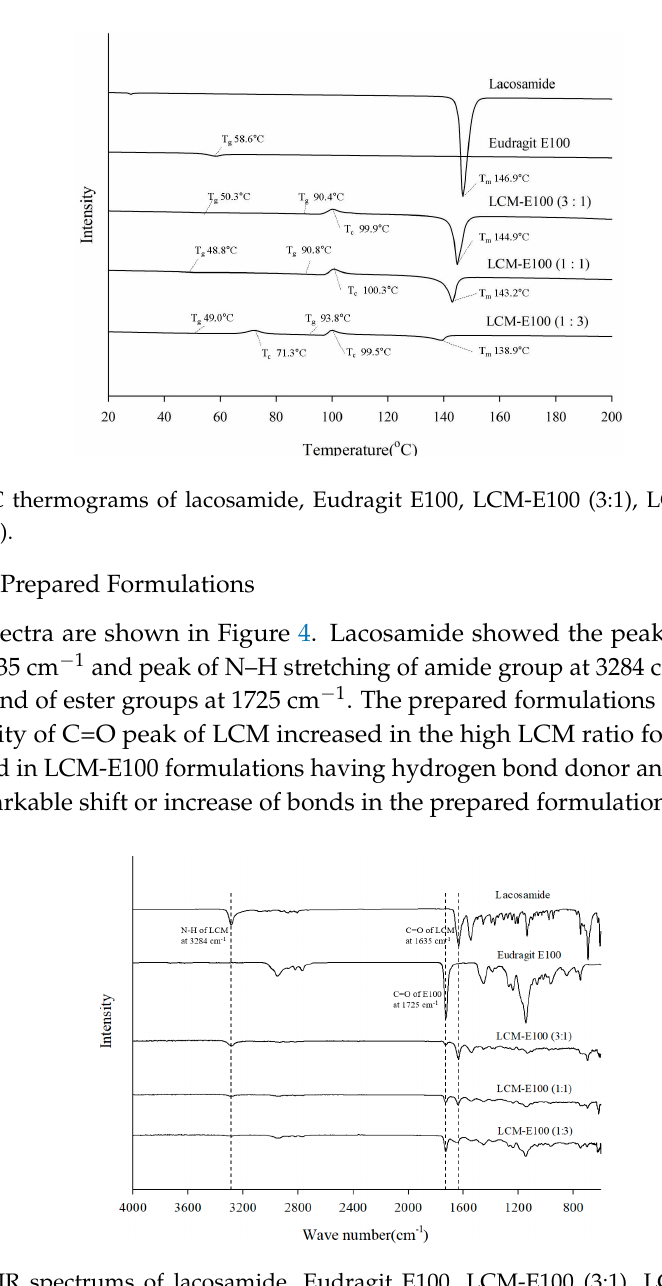
Figure 4. FT-IR spectrums of lacosamide, Eudragit E100, LCM-E100 (3:1), LCM-E100 (1:1) and LCM-E100 (1:3).